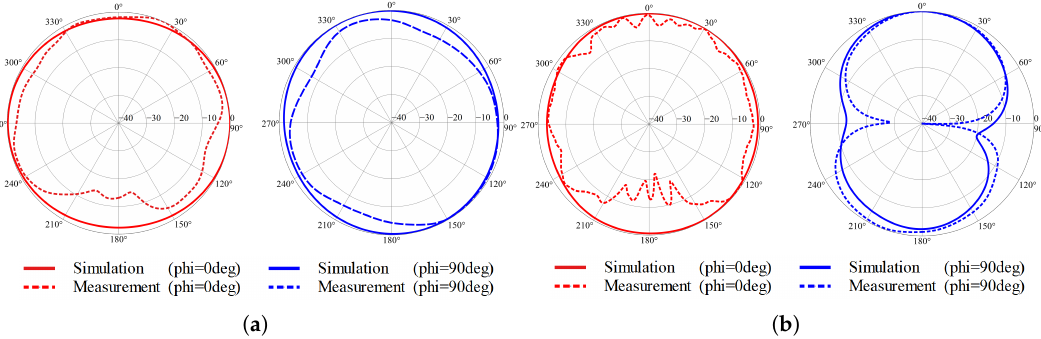
Figure 13. Measured normalized radiation pattern of the antenna at ( a ) low-frequency band and ( b ) high-frequency band.